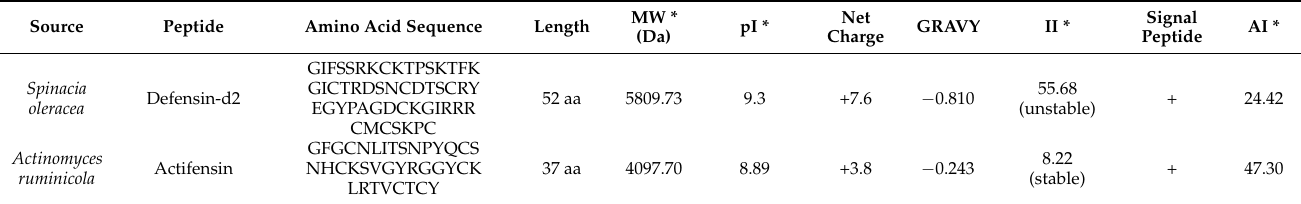
Table 1. In silico characterization of the peptides.